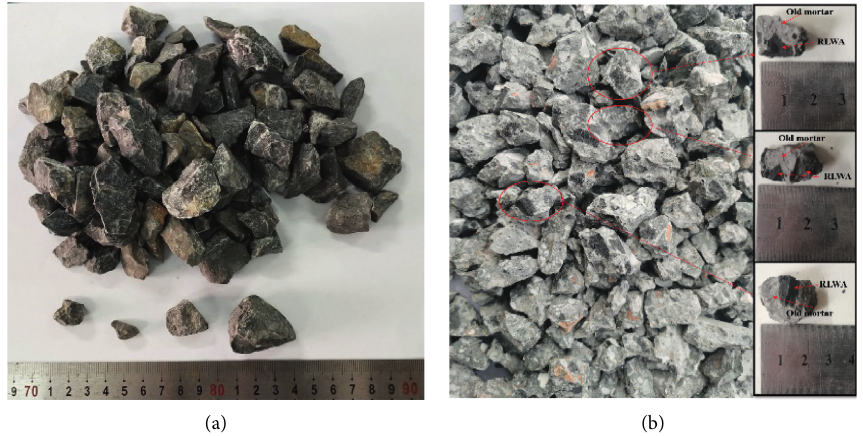
Figure 2: Coarse aggregate. (a) Natural coarse aggregate and (b) recycled lightweight coarse aggregate.